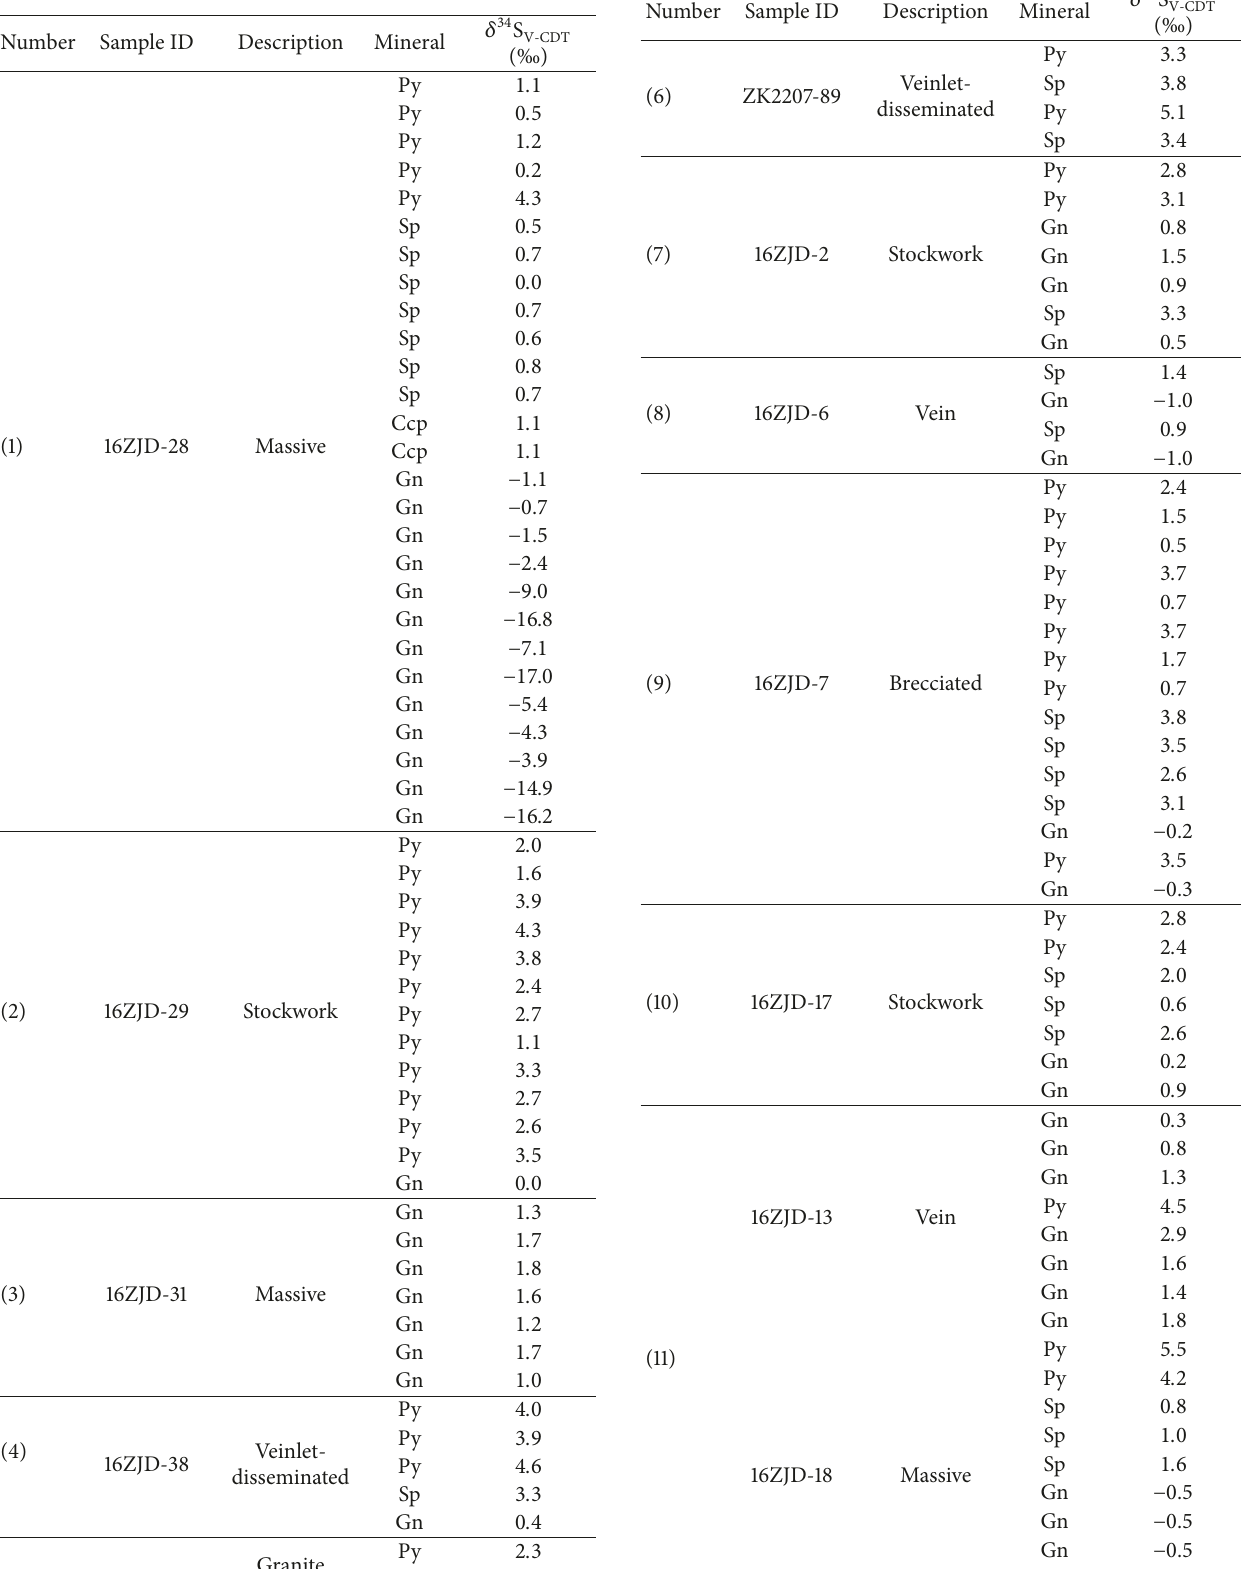
Table 3: Sulfur isotope data of sulfide minerals from the Zhijiadi Ag-Pb-Zn